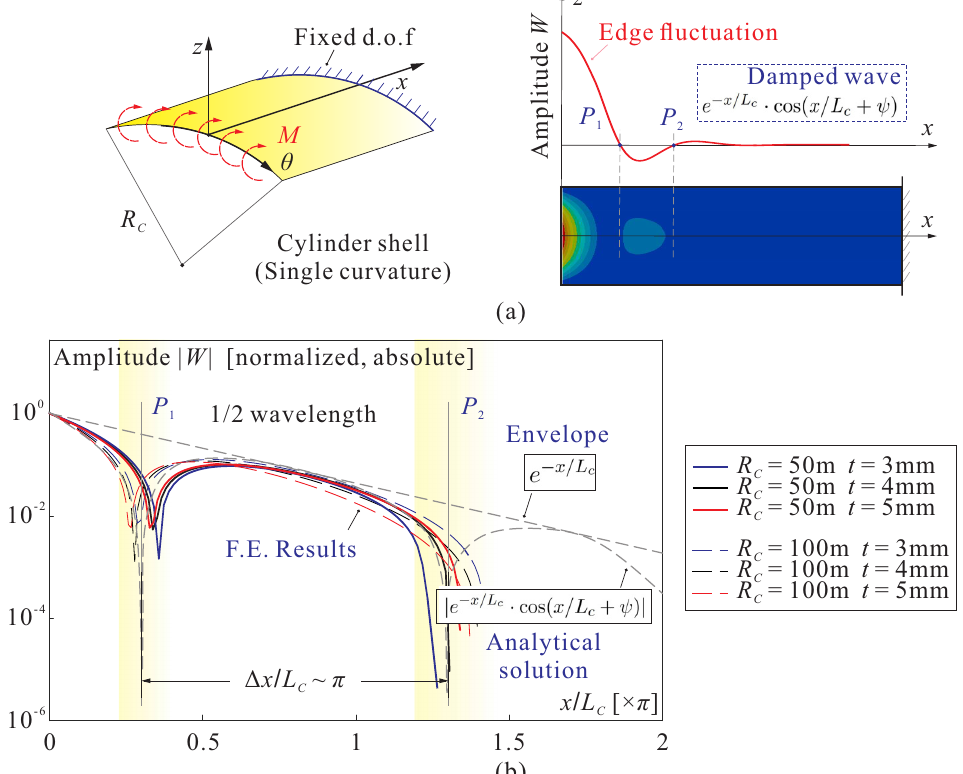
Figure 4. Numerical verification of damped wavy deformation on the edge of a cylinder thin shell with a single curvature ( c 1 = 1/ R C , c 2 = 0), where the characteristic length L C = 0.76 various radii of curvature R C and thickness t are tested, showing a good agreement with the analytical solution of Equation (5): ( a ) an illustration of the numerical model of a cylinder shell deformed by a moment load; ( b ) the comparison between the numerical results of the deformation in axial direction and the analytical solution of Equation